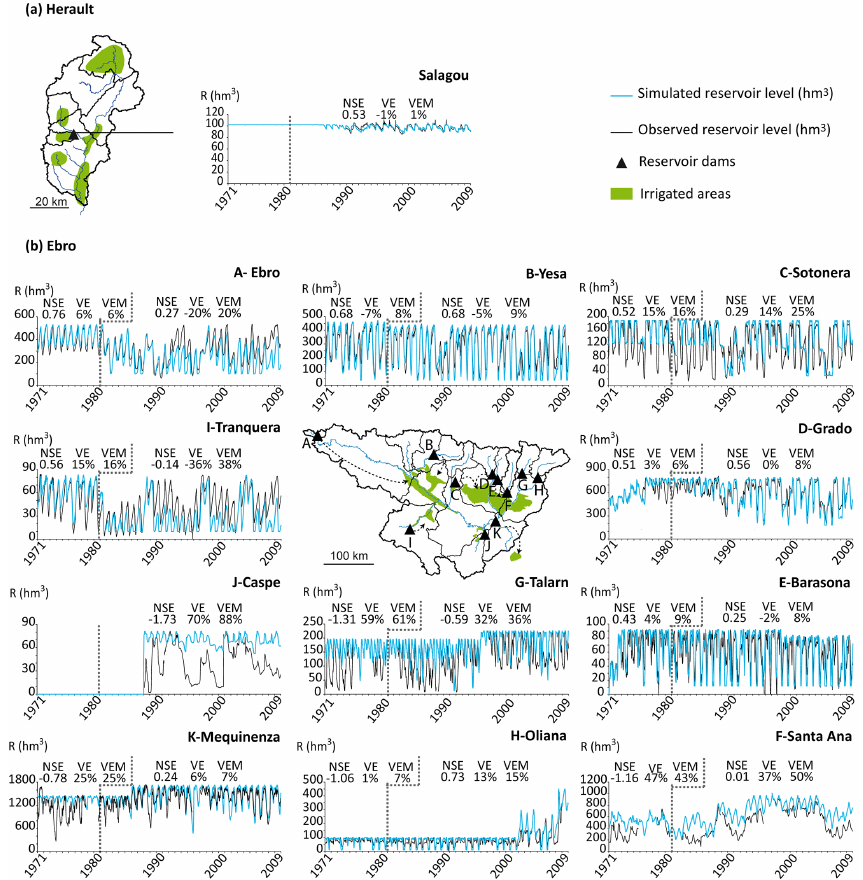
Figure 6. Simulated and observed reservoir levels ( R ) of the main dams in (a) the Hérault Basin and (b) the Ebro Basin. Results for the periods over which simulations of natural streamflow were calibrated (1981–2009) and validated (1971–1980) are marked with a grey dotted line. Optimal values of NSE, VE and VEM are 1, 0 and 0,